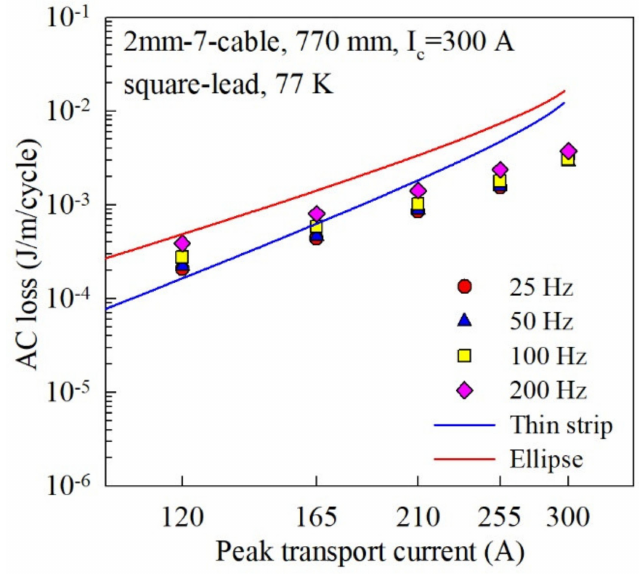
Figure 8. Effect of frequency on AC loss of 2 mm − 7 −